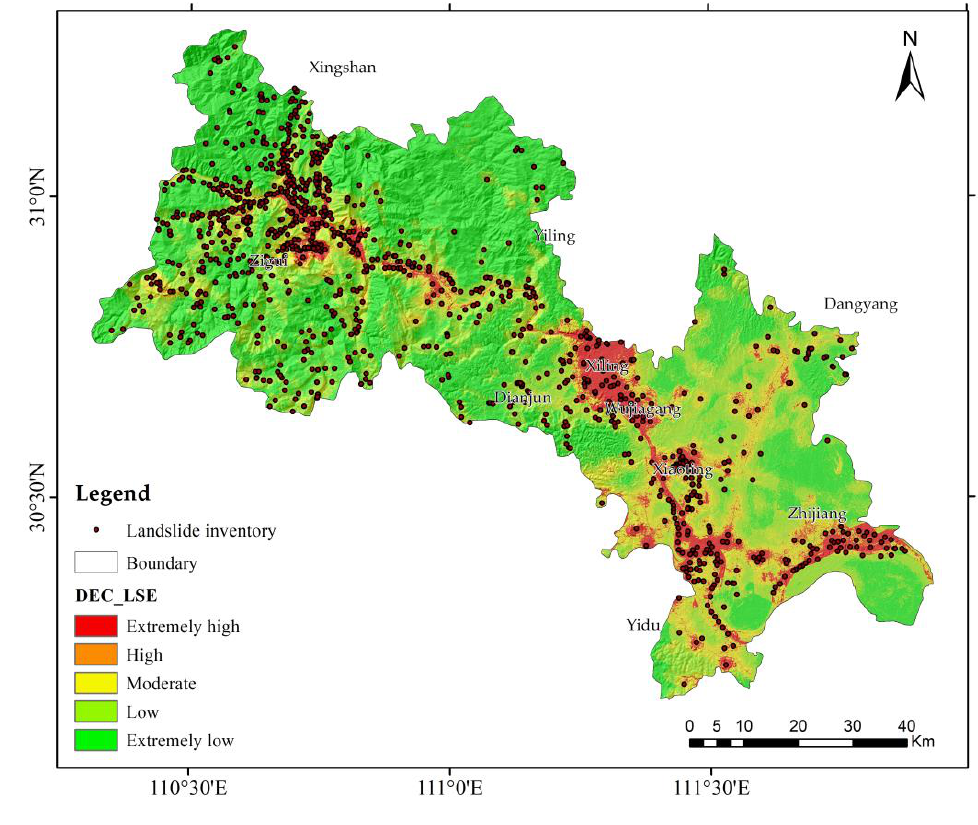
Figure 8. LSE result based on DEC. Table 2. DEC-Result.